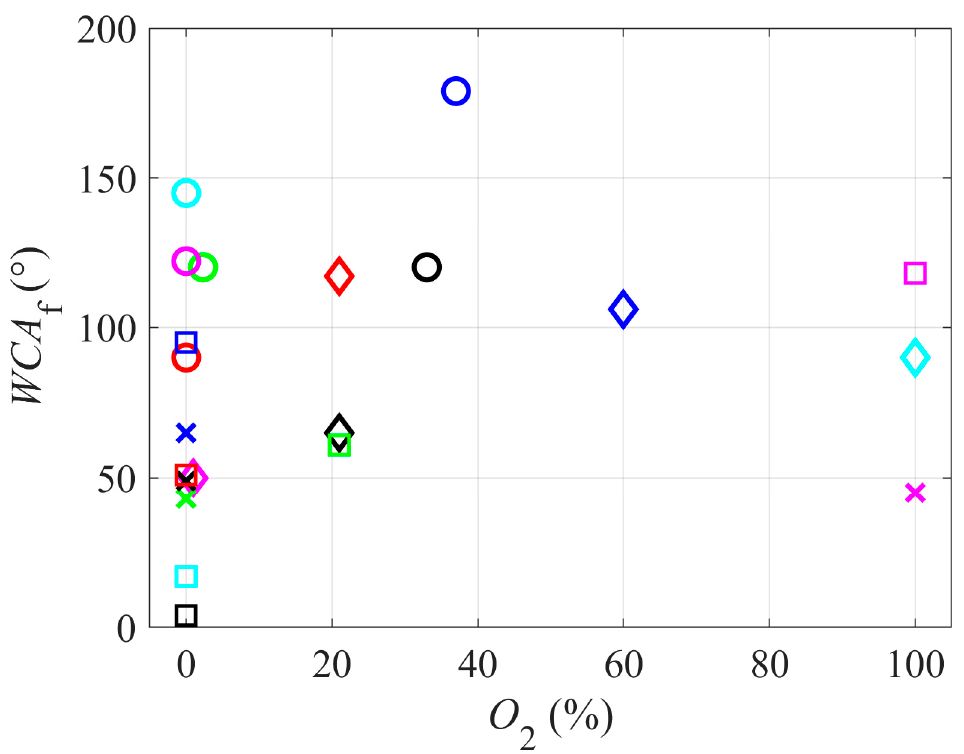
Figure 3. Water contact angle versus the concentration of oxygen in the gaseous plasma.